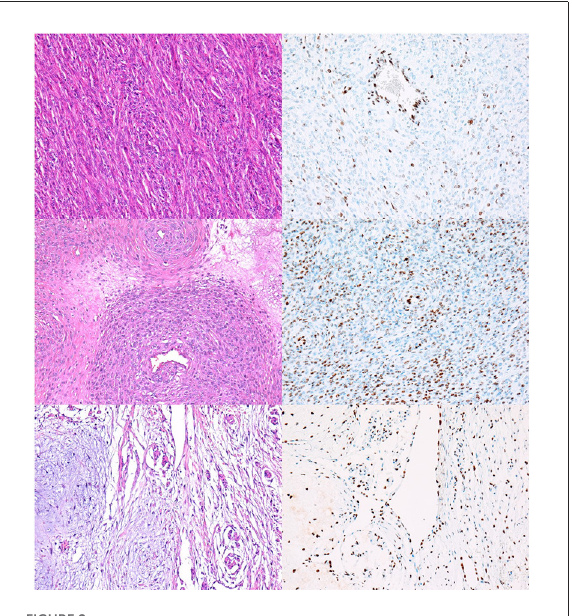
FIGURE1 NSTs with complete loss of H3K27me3 expression. (A,B) MNST with perineural differentiation. HE, 200x (A) , and H3K27me3, 200x (B) . (C,D) Neurofibroma. HE, 200x (C) , and H3K27me3, 200x (D) . In Figures (B,D) only endothelial cells and scattered lymphocytes express H3K27me3, whereas tumor cells are immunonegative. (E,F) Conventional MNST, HE, 200x (E) . Tumor exhibits geographical loss of H3K27me3 expression, H3K27me3, 100x (F) .